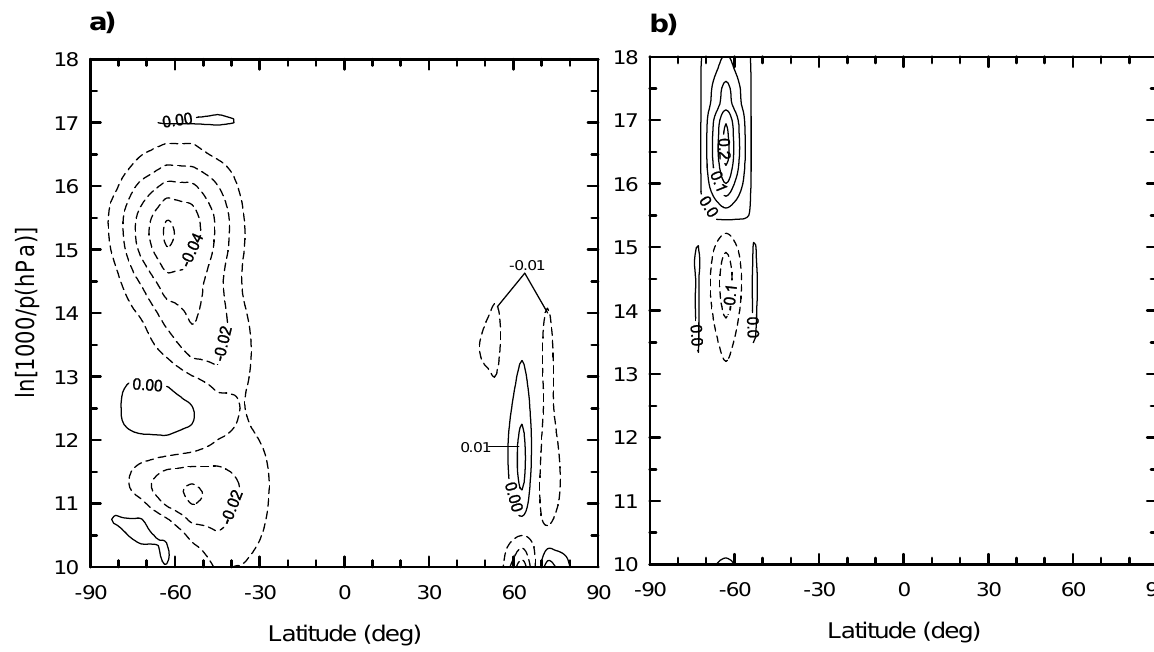
Fig. 13. As in Fig. 10, but for the 16-day wave.